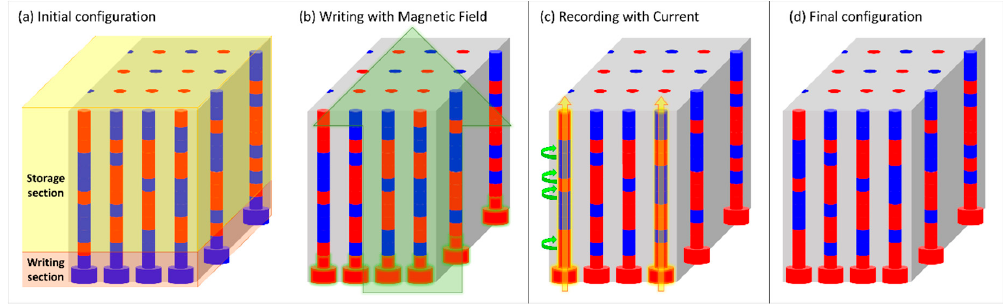
Figure 7. Schematic representations of the ( b ) writing and ( c ) recording processes in a 3D racetrack memory device changing the stored information from ( a ) initial to ( d ) final configuration. Red (blue) segments correspond to magnetic domains pointing up (down). Yellow arrows in ( c ) indicate the application of a spin-polarized current along the respective